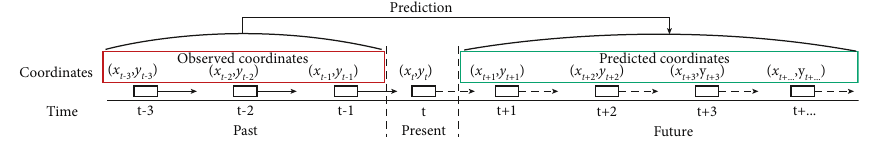
Figure 1: A recursive algorithm for predicting coordinates by time.